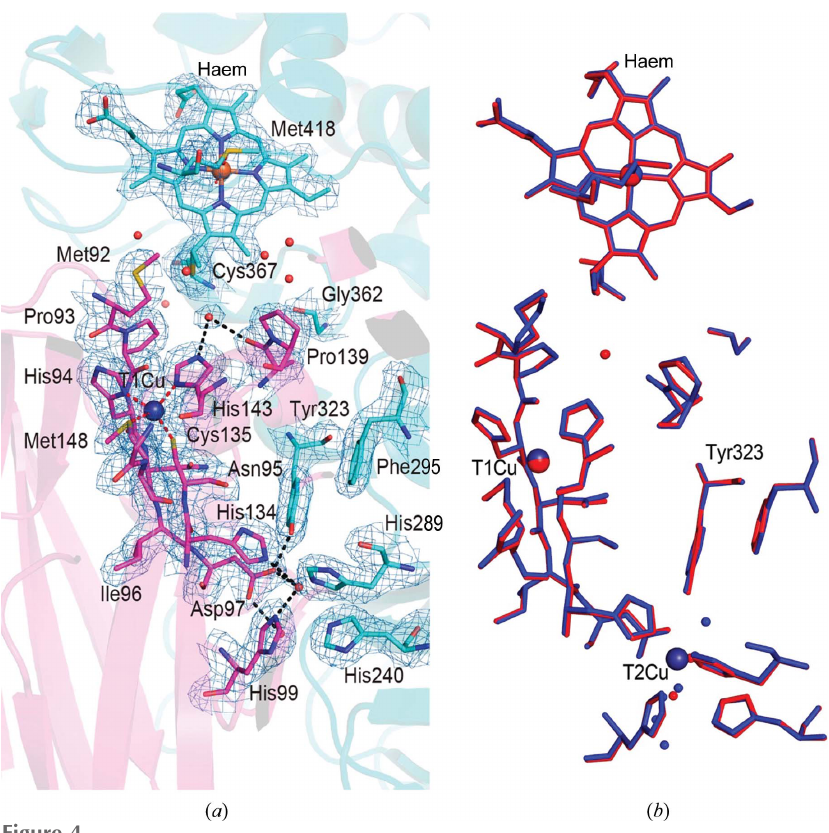
Figure 4 Cytochrome and copper-binding domains in T2D Rp NiR and comparison with the fully copper- loaded structure. ( a ) T2D Rp NiR has no copper in the T2Cu site. Tyr323 has remained ligated to Asp97 and water and is in the locked position. 2 F o (cid:2) F c electron-density map is shown at 1.0 (cid:5) (blue mesh). ( b ) Alignment of the T2D Rp NiR structure (red) with the untreated wt Rp NiR atomic resolution structure (blue; PDB entry 3ziy) showing close structural similarities, with Tyr323 in an identical position in T2D Rp NiR despite the absence of